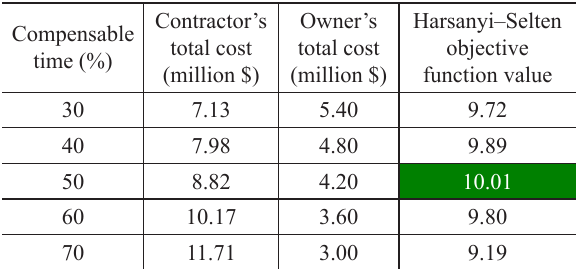
Table 3. Harsanyi- Selten objective function value (with parties’ different bargaining power)